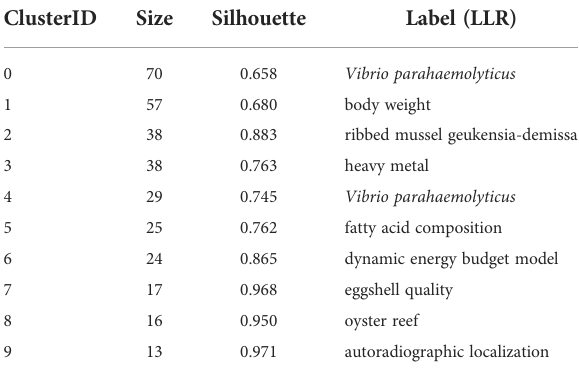
TABLE 3 Top ten cluster analysis based on the given keyword of the oyster research.